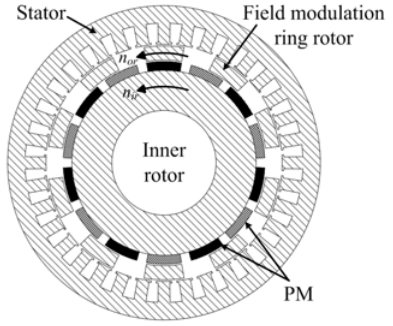
Figure 24. Structure of the magnetic-geared dual-rotor brushless machine (MGDRM).